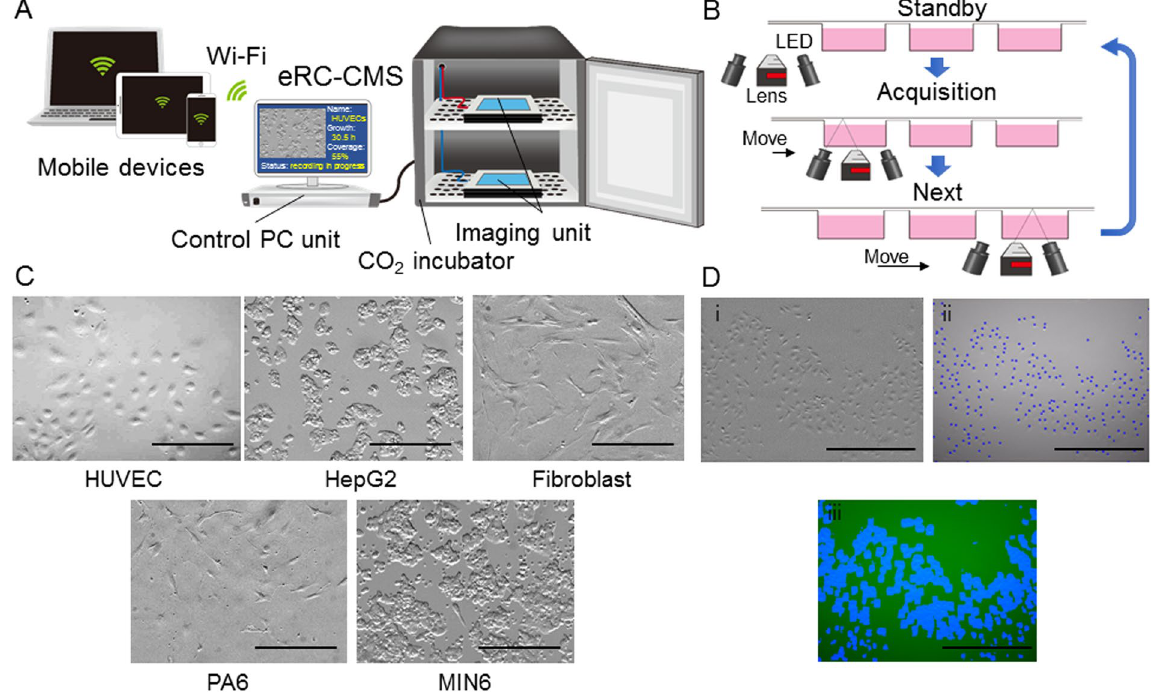
Figure 1. Flatbed epi relief contrast cellular monitoring system (eRC-CMS). ( A ) Configuration and culture scheme. eRC-CMS consisted of an imaging unit, control unit, and PC. The imaging unit was equipped with an objective lens and LEDs for epi relief contrast imaging. HUVEC images were automatically acquired every 60 min from 24 to 72 hours of culture in a 6-well plate. Image data were automatically processed with custom software to obtain the cell number, confluency, and cell circularity. ( B ) Examined regions. Cell images (1.2 mm × 0.8 mm) were acquired at 5 different regions in each well in a 6-well plate (a total of 30 regions/ plate). ( C ) Image analysis. An acquired cell image (i) was automatically processed and labelled with blue dots for counting the cell numbers (ii) or was transformed to a binary image for the quantification of confluency (iii). Scale bars: 500 μ m. ( D ) Comparisons of images of different types of cells. Scale bars: 200 μ